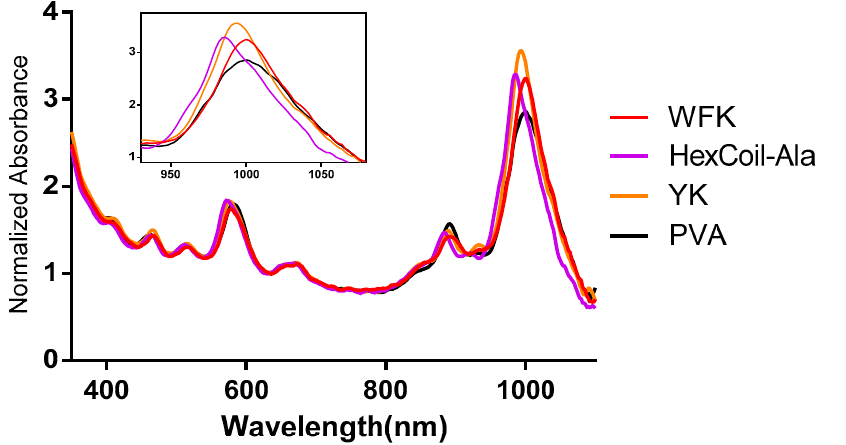
Figure 3. UV–visible absorption spectra of WFK, YK, HexCoil-Ala, and PVA-encapsulated (6,5) SWCNTs. The insert presents the 950–1050 nm part of the spectrum.